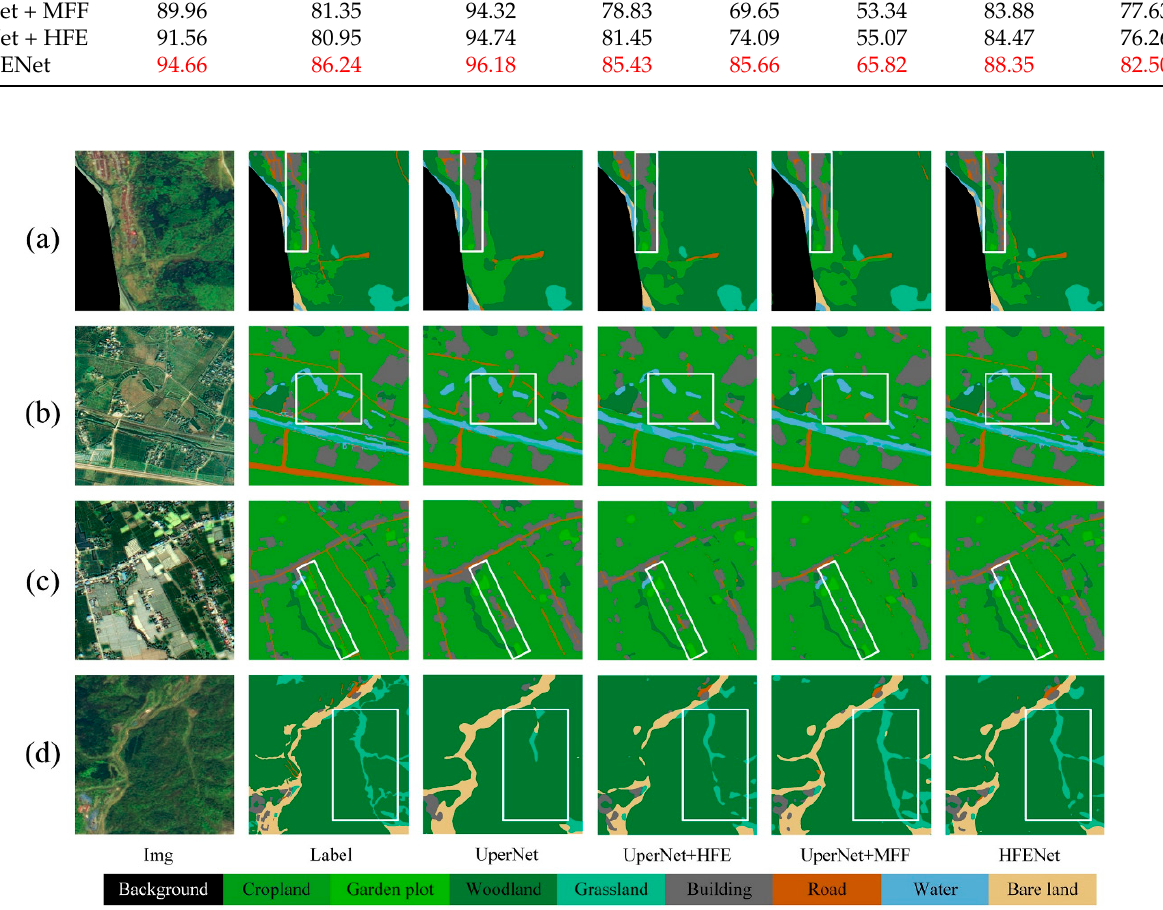
Figure 8. Comparison of the classification results of HFE and MMF combination on MZData. ( a – c ) shows the typical case that it is difficult to identify roads in small-scale features. ( d ) shows the complex scenes where woodland and grassland are easily confused. (HFENet is equivalent to UperNet + HFE + MFF).